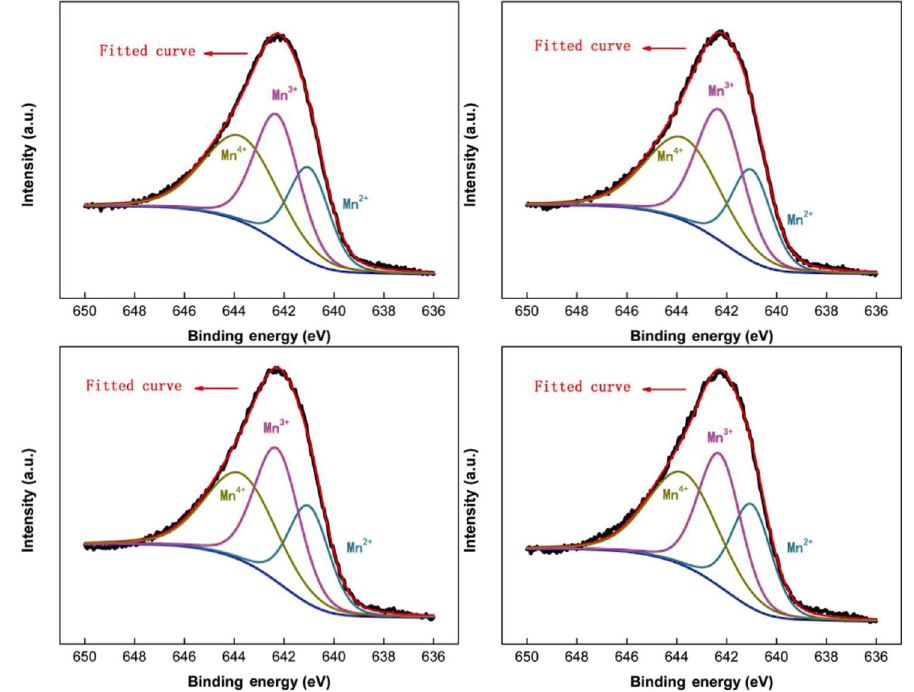
Fig. 5 XPS fitting of Mn 2p 3/2 signals of MCNO thin films at different annealing temperat ures: (a) 700 ℃ , (b) 750 ℃ , (c) 800 ℃ , (d) 850 ℃